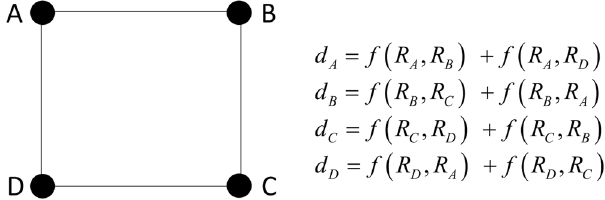
Figure 1. Regular network: the degree